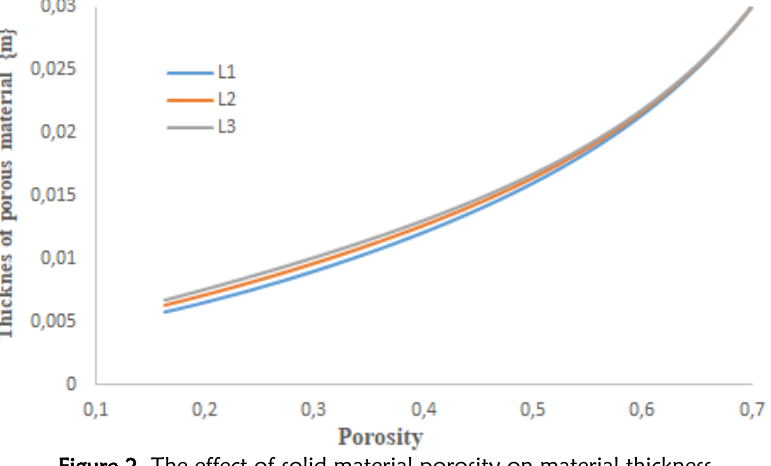
Figure 2. The effect of solid material porosity on material thickness